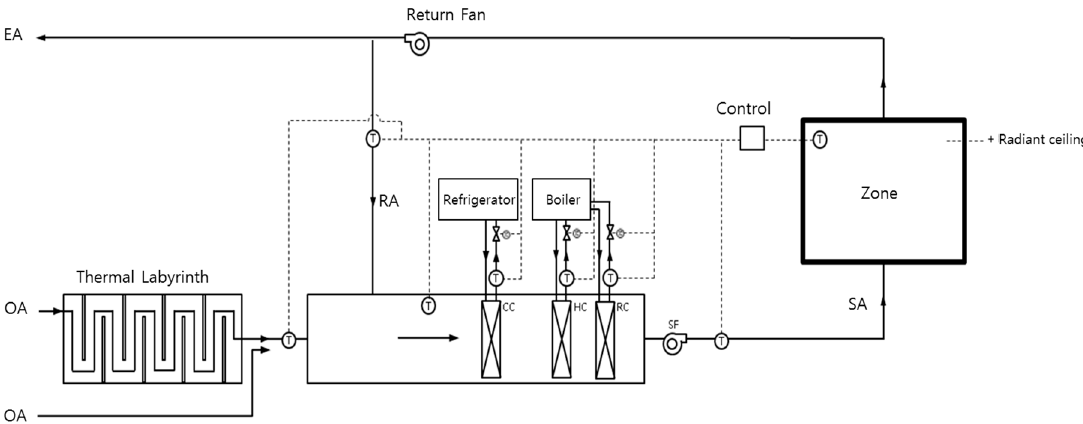
Figure 13. System construction in the studied building.